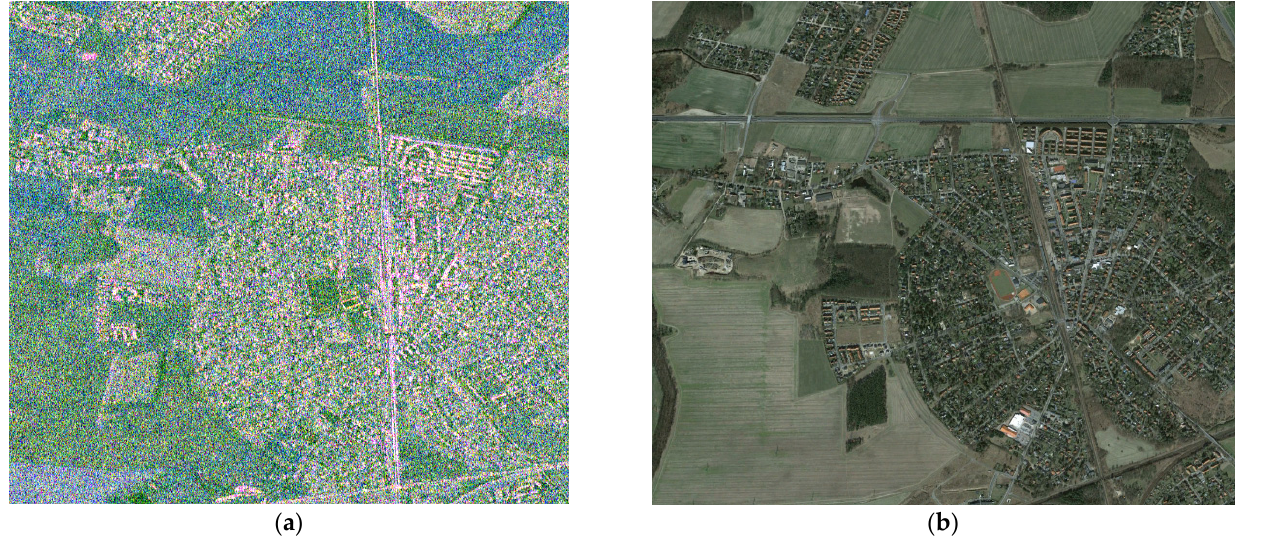
Figure 6. ( a ): Pauli-coded color composition of polarimetric channels (red: |hh-vv|, green: |hv|, blue: |hh+vv|). ( b ): optical image of studied region (source: Google Earth).